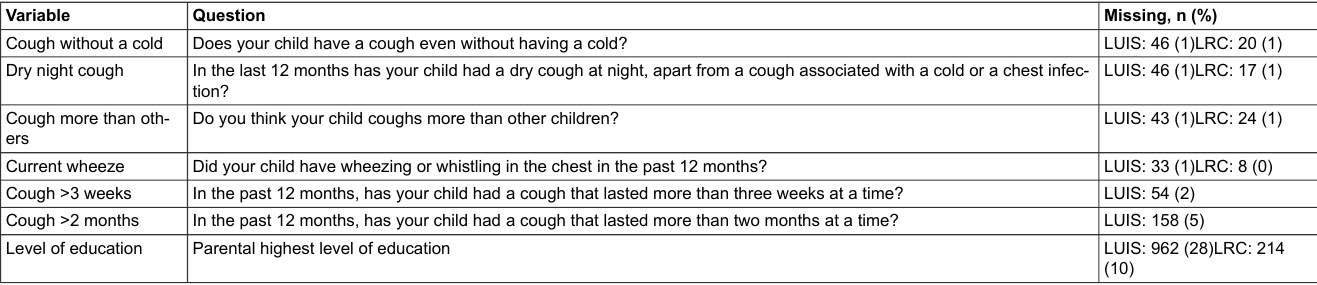
Table S1: Wording of questions and frequency of missing values in the LuftiBus in the School (LUIS) study and Leicester Respiratory Cohort (LRC). Variable